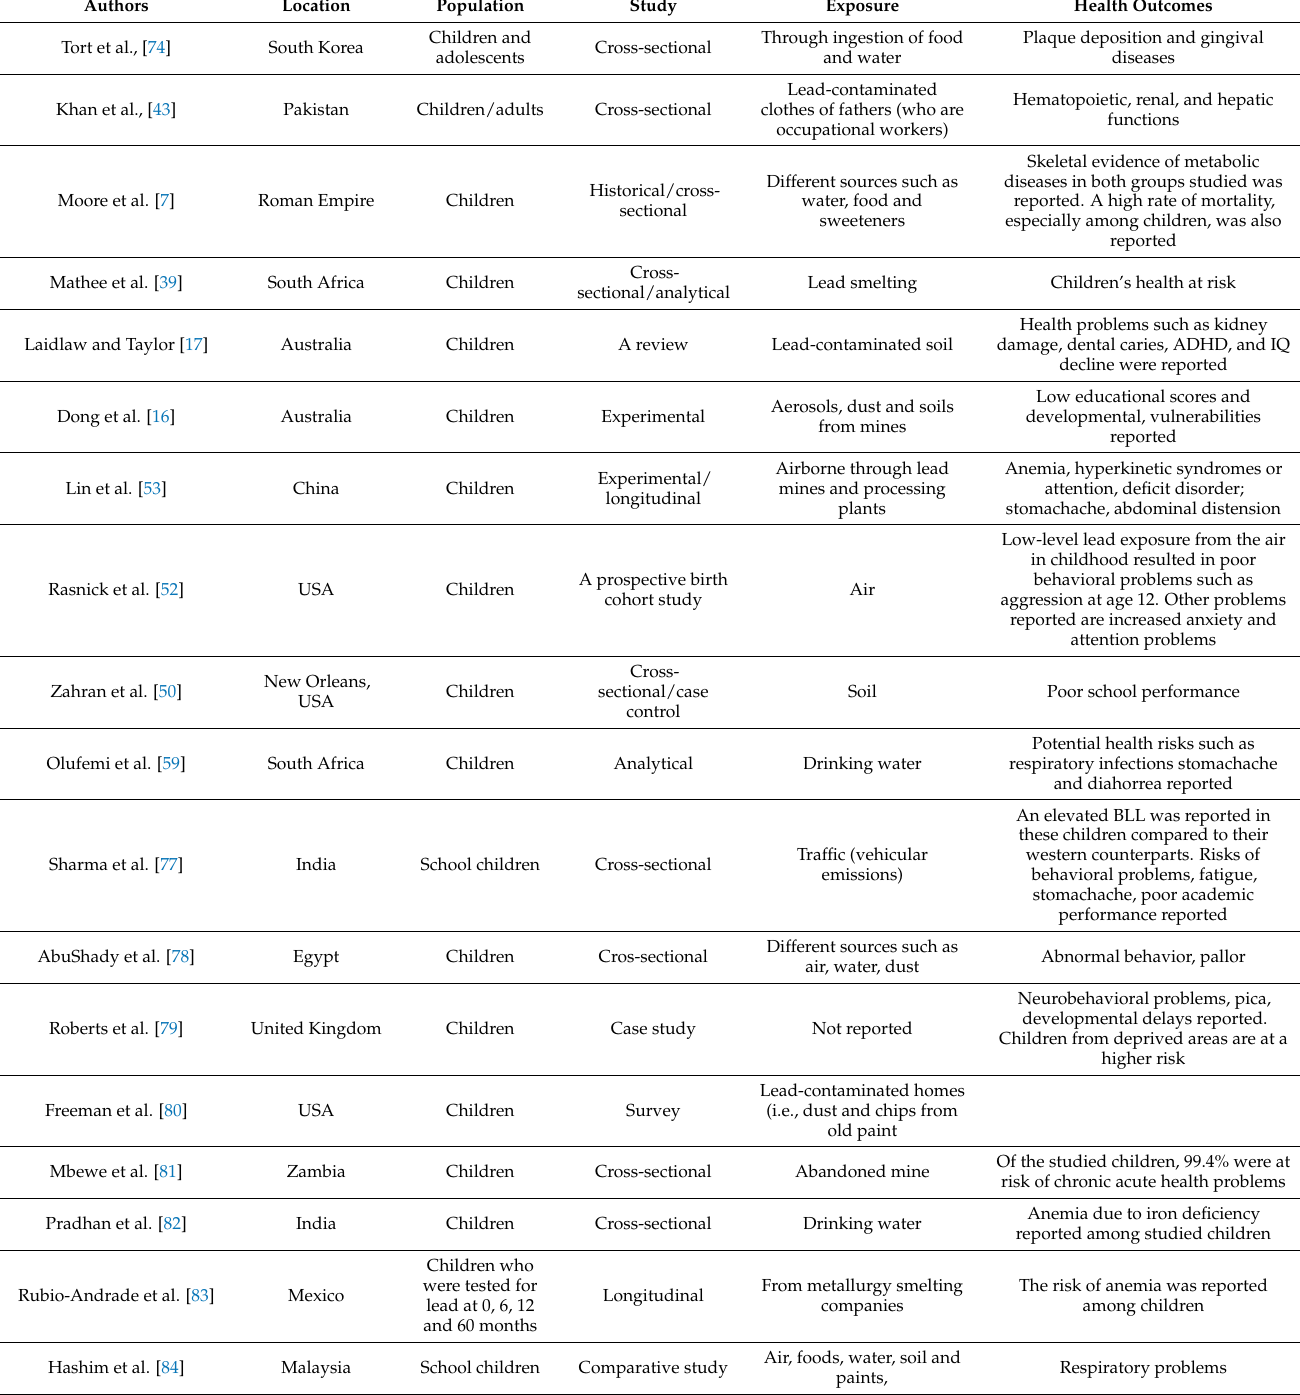
Table 4. Summary of epidemiological and scientific studies on health effects of lead exposure on children from different